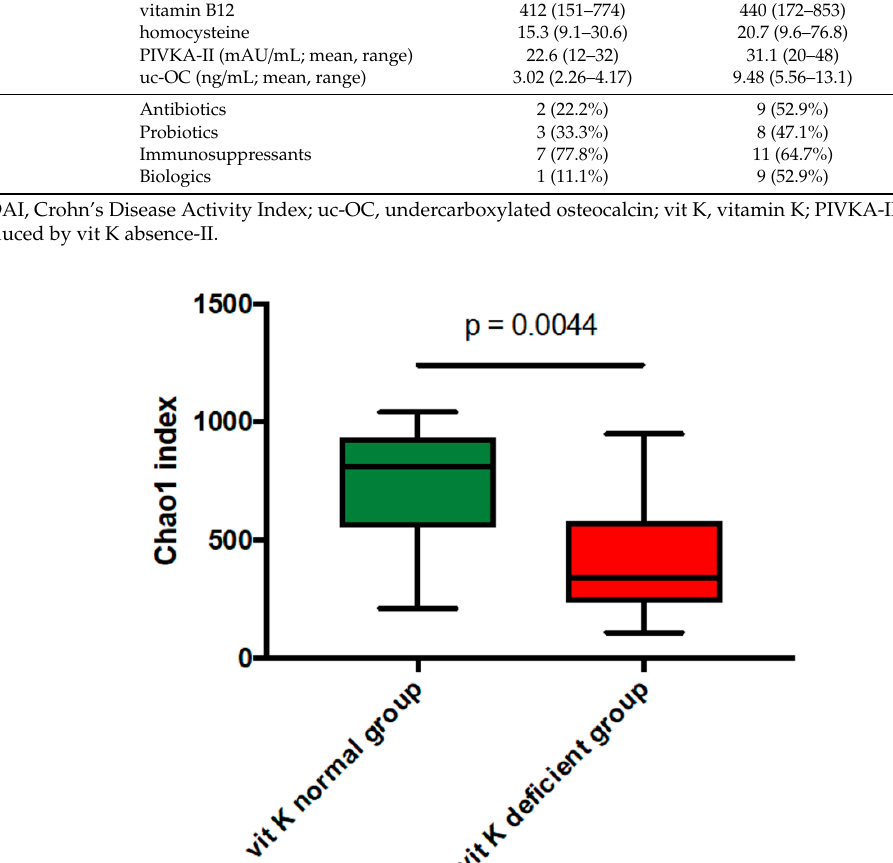
Figure 2. Correlation between undercarboxylated osteocalcin concentration and mean Chao1 index in cases of low activity. There was also a significant negative correlation between undercarboxylated osteocalcin concentration and mean Chao1 index in cases of low activity (Crohn's Disease Activity Index: CDAI <150). uc-OC, undercarboxylated osteocalcin.